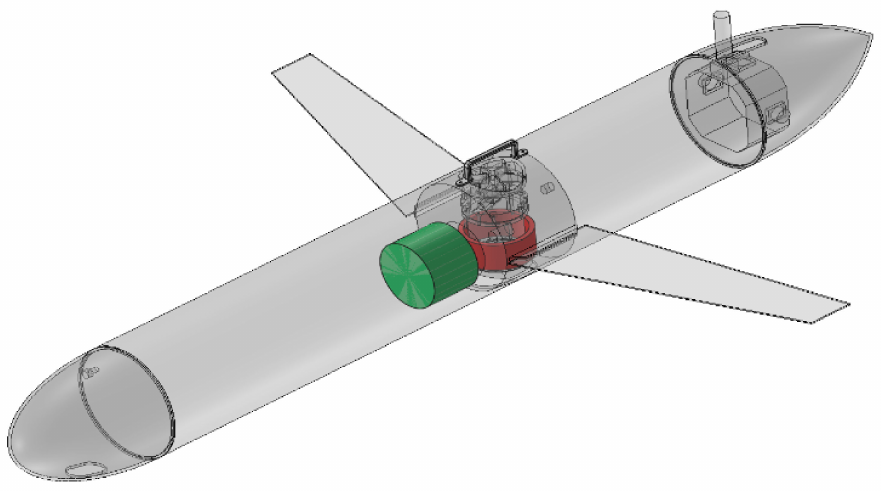
Figure 16. Buoyancy of the